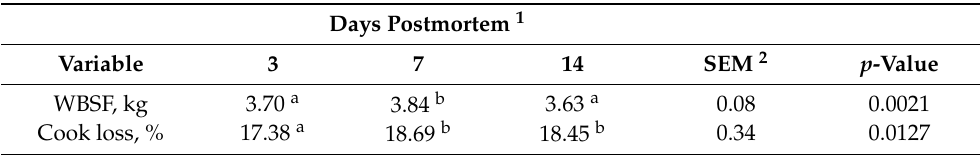
Table 3. Least square means for Warner–Bratzler Shear Force (WBSF) and cook loss values of beef steaks aged 3, 7, or 14 d 1 (n = 42/day).